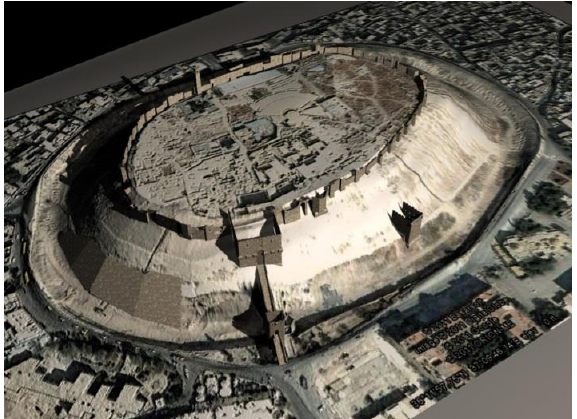
Figure 20. The 3D model of the Citadel (Livia Piemattei)